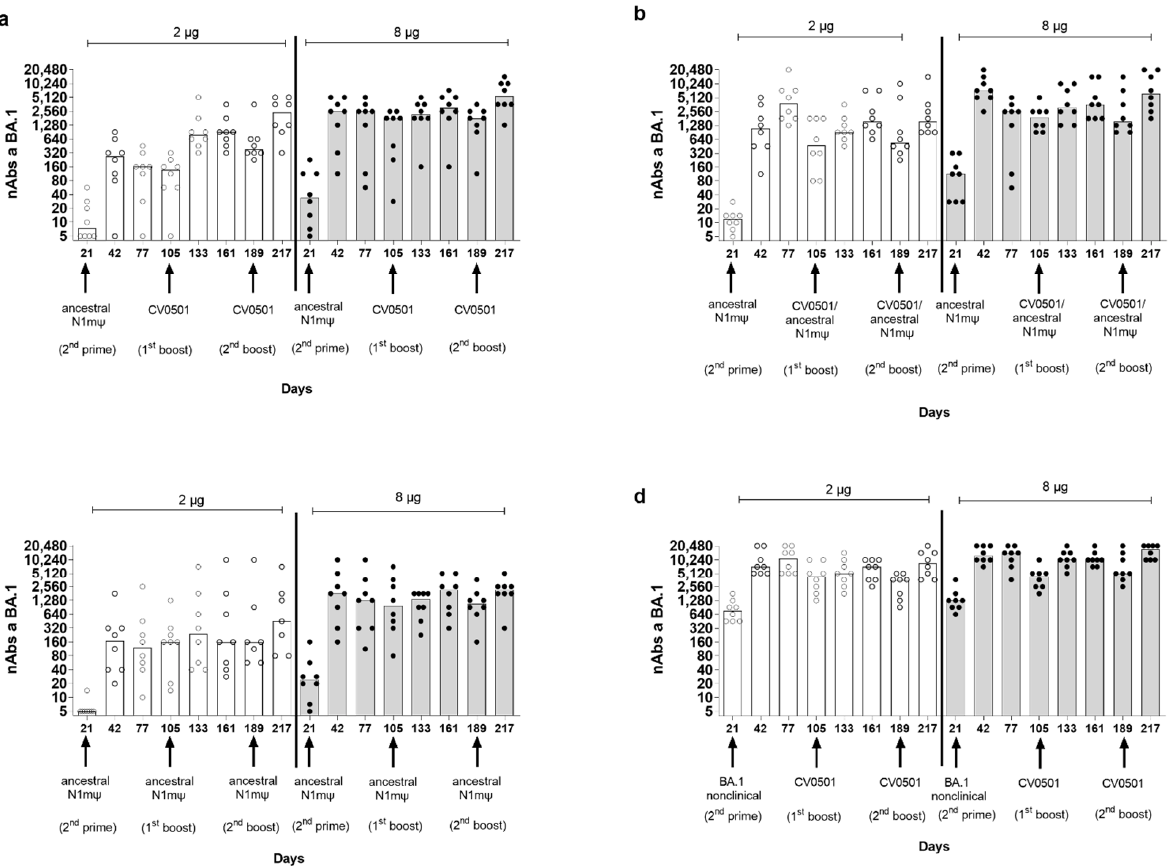
Figure 3. CV0501 and bivalent CV0501/ancestral N1m Ψ boost nAb titers against BA.1 after priming with ancestral N1m Ψ vaccine. Wistar rats ( n = 8/group) were immunized i.m. (1st and 2nd prime) on Days 0 and 21 with either 2 µg (clear circles, white bars) or 8 µg (black circles, grey bars) doses of ancestral N1m Ψ or BA.1 nonclinical. On Days 105 and 189, rats were given a third and fourth dose (1st and 2nd boost) of either ( a , d ) CV0501, ( b ) bivalent CV0501/ancestral N1m Ψ (half doses of each), ( c ) ancestral N1m Ψ (2 µg or 8 µg doses). nAbs against BA.1 SARS-CoV-2 were assessed in sera obtained on Days 21, 42, 77, 105, 133, 161, 189 and 217. Each symbol represents an individual rat and the bars represent the median value. Analyses of nAb titers were performed on separate days for each timepoint. One-way ANOVAs and Kruskal-Wallis tests were performed to compare nAb titers between Days 105 and 133 and between Days 189 and 217. Table 2. Analyses of median nAb production against SARS-CoV-2 variant BA.1 after booster vac- The lowest nAb levels against BA.1 were observed in ancestral N1m Ψ -primed/ancestral N1m Ψ boosted animals and the highest nAb levels against BA.1 were observed in